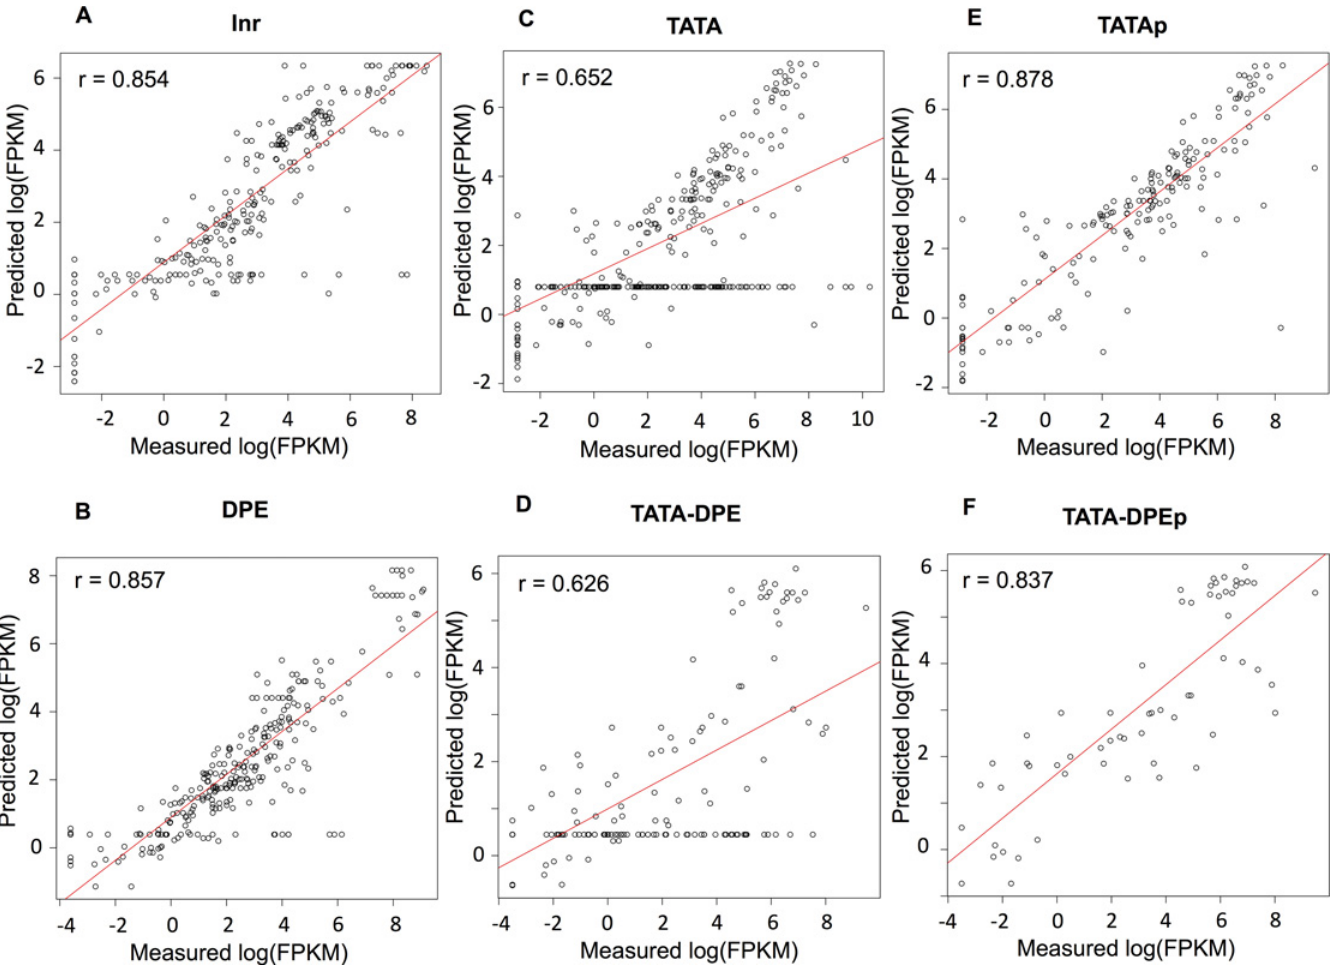
Fig 4. Comparison of the histone modification dependency of RNA expression values by random forest. Non-linear regression by random forest was performed and the correlation between the measured and predicted log(FPKM) has been represented by a scatterplot. (A) Scatterplot between the measured and predicted log(FPKM) in the Inr group ( n = (24 core promoters ) × (11 developmental stages ) = 264). The correlation coefficient was r = 0.854. (B) Scatterplot between the measured and predicted log(FPKM) in the DPE group ( n = (25 core promoters ) × (11 developmental stages ) = 275). The correlation coefficient was r = 0.857. (C) Scatterplot between the measured and predicted log(FPKM) in the TATA group ( n = (33 core promoters ) × (11 developmental stages ) = 363). The correlation coefficient was r = 0.652. (D) Scatterplot between the measured and predicted log(FPKM) in the TATA-DPE group ( n = (14 core promoters ) × (11 developmental stages ) = 154). The correlation coefficient was r = 0.626. The TATA and TATA-DPE groups were divided into two types based on the distributions in the scatterplots. (E) Scatterplot between the measured and predicted log(FPKM) in the TATAp group (n = 178, for details see the Methods). The correlation coefficient was r = 0.878. (F) Scatterplot between the measured and predicted log(FPKM) in the TATA-DPEp group (n = 46, for details see the Methods). The correlation coefficient was r =